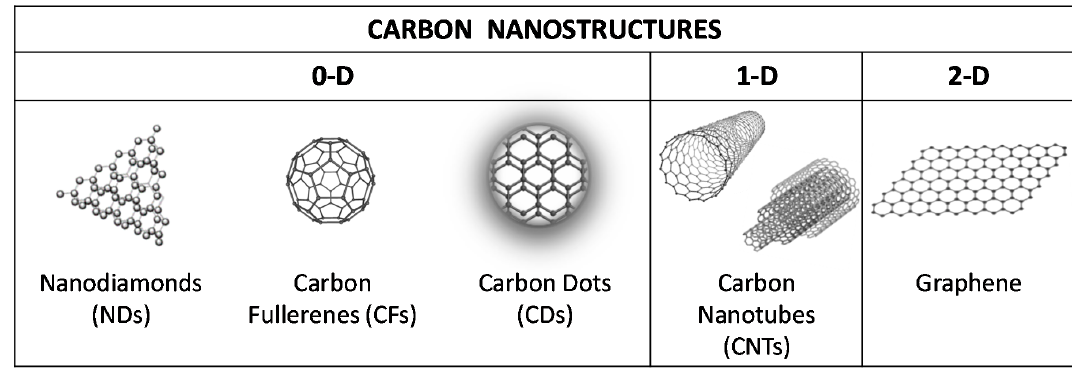
Figure 1. Main forms of carbon nanostructures (not to scale).